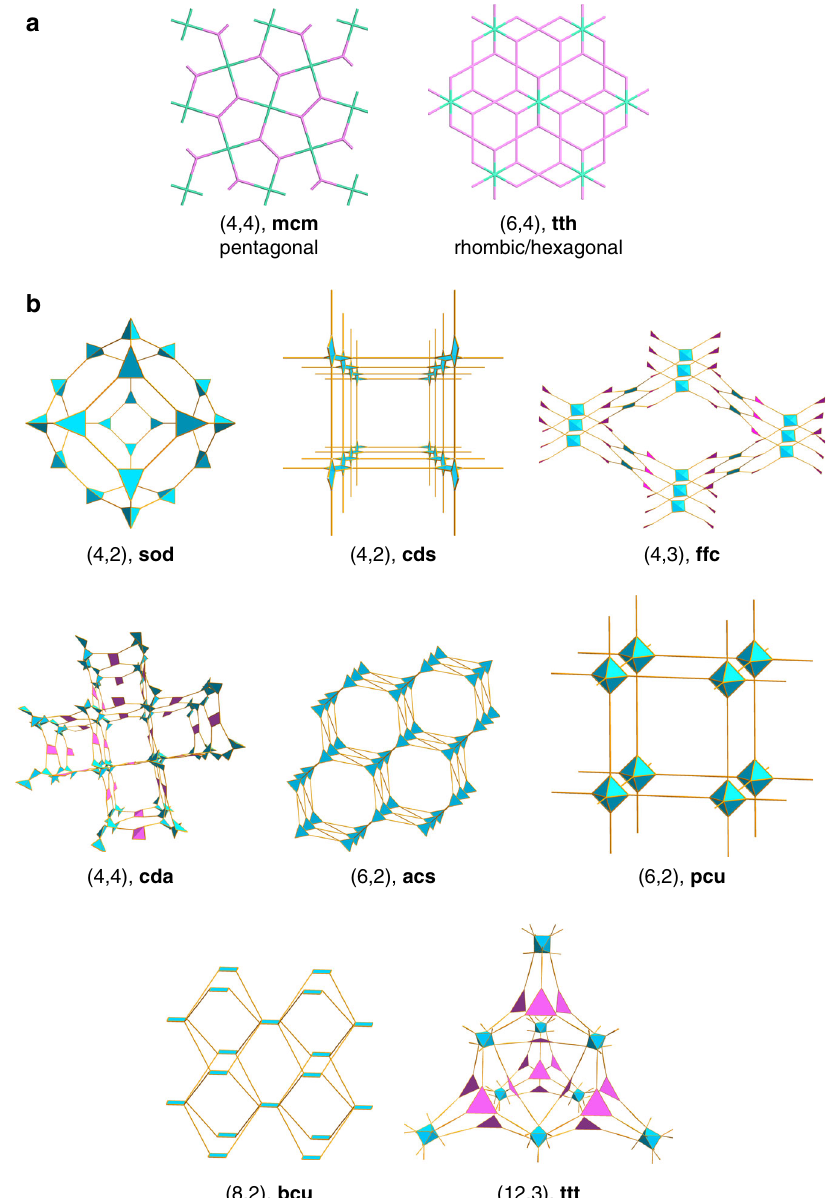
Fig. 3 Unreported topologies for the designed COFs. a 2D-COFs. b